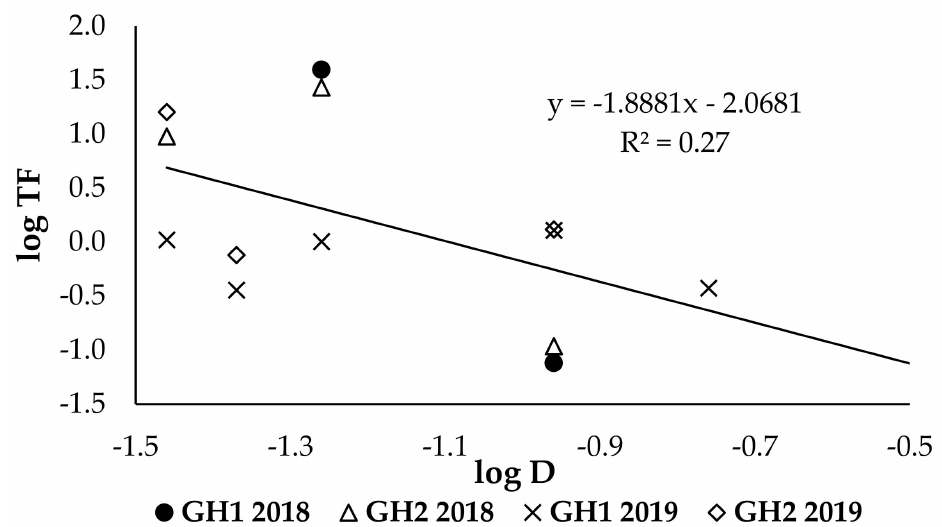
Figure 2. Correlation between log TF and log D of target sulfonamides in soils and RWW.